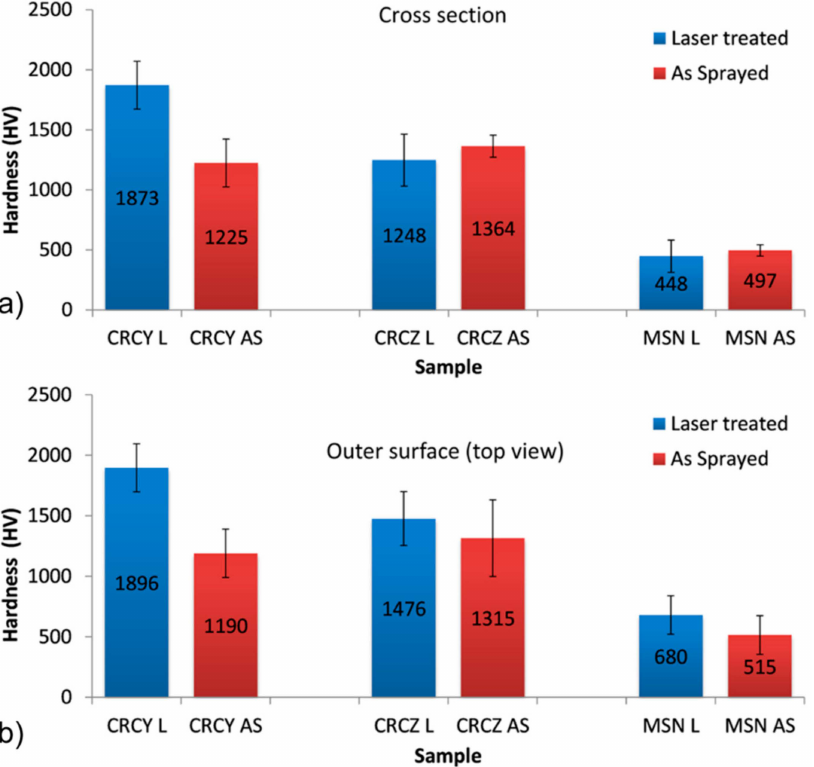
Figure 6. Microhardness of the as-sprayed (AS) and laser-treated (L) samples measured on the cross-section ( a ) and the top surface ( b ) (error bars indicate +/ − standard